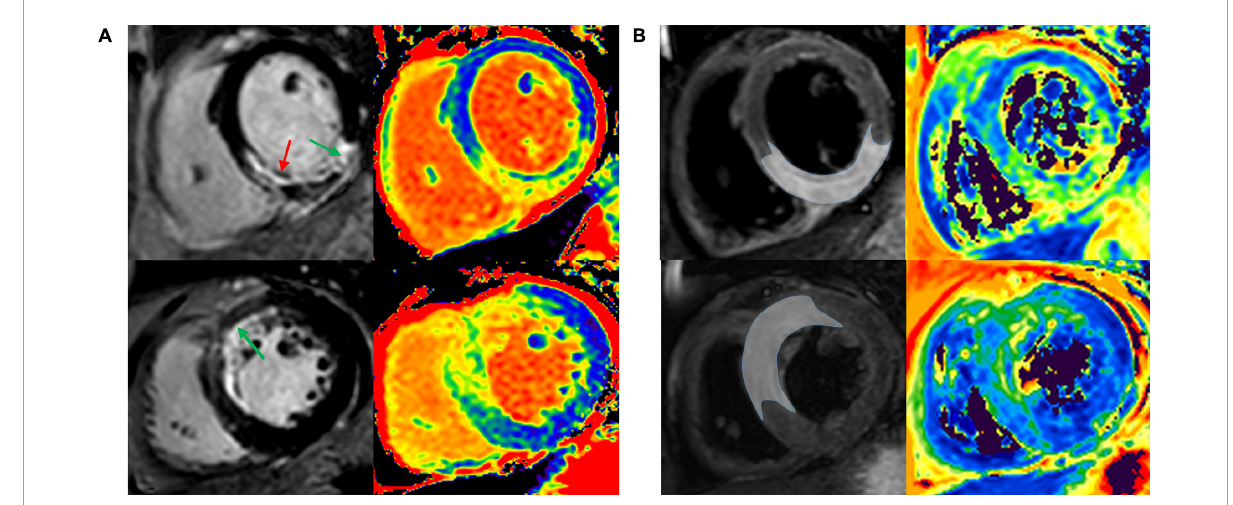
FIGURE1 Infarct region and AAR were validated by comparing T1 and T2 mapping against LGE and T2w-STIR. Representative images of patient with acute anterior and anteroseptal STEMI (A) , and patient with acute inferior and inferoseptal STEMI (B) . AAR, area at risk; LGE, late gadolinium enhancement; T2w-STIR, T2-weighted short tau inversion recovery; STEMI, ST-segment elevation myocardial infarction.